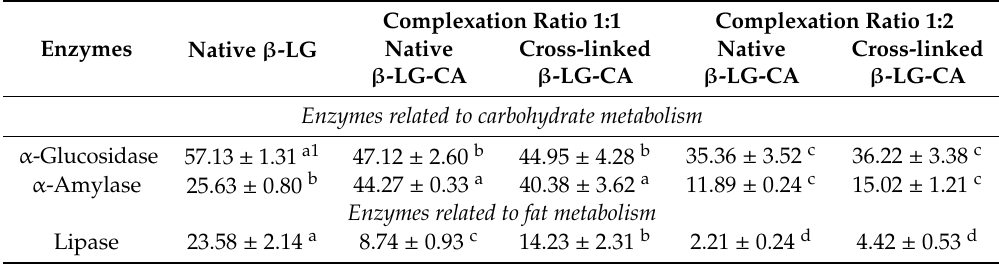
Table 4. Inhibitory e ff ect of complexes between ca ff eic acid (CA) and β -LG on enzymes involved in carbohydrates and fats